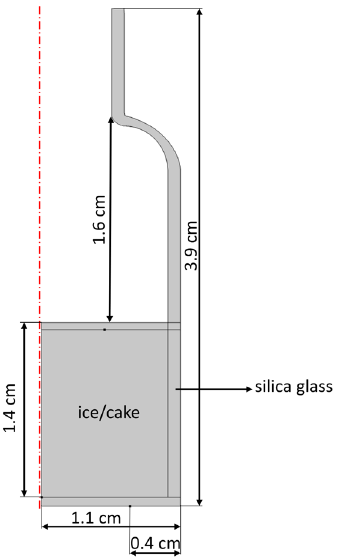
Figure 7. Simplified SCHOTT 6R vial geometry used in simulation.